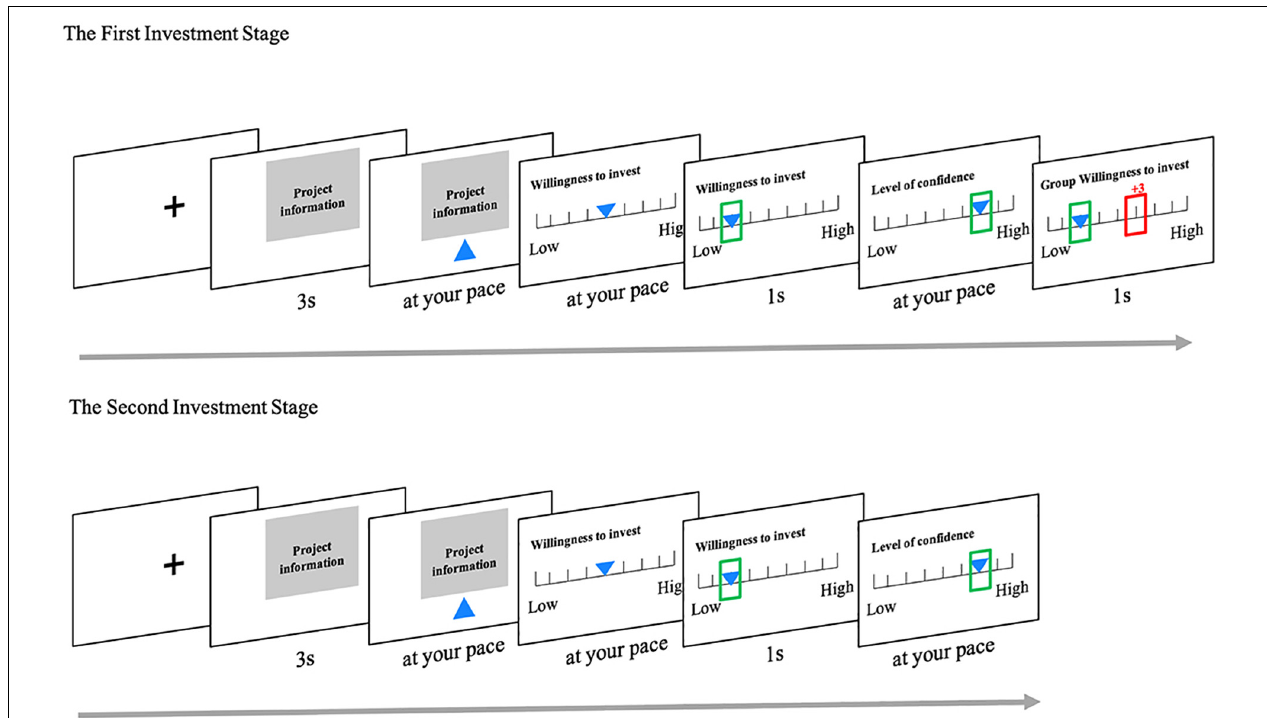
FIGURE 1 | At the first stage, participants were instructed to learn the crowdfunding project for at least 3s (Participants could not go to the next page until the blue triangle appeared under the project picture) and then rated their willingness to invest this project as well as the confidence level about the decision by moving the cursor (a blue inverted triangle). Their ratings were highlighted by a green frame. At last, the group rating of willingness-to-invest was presented by a red frame with the rating difference from the participants above it. At the second stage, participants would rate the willingness-to-invest of the same projects and the corresponding confidence